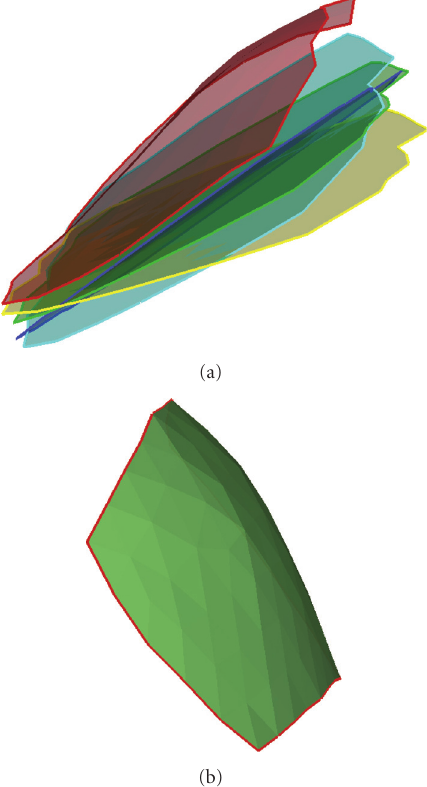
Figure 7: Comparison of paddle locations in four loadings. Note that the right paddle is fixed for all